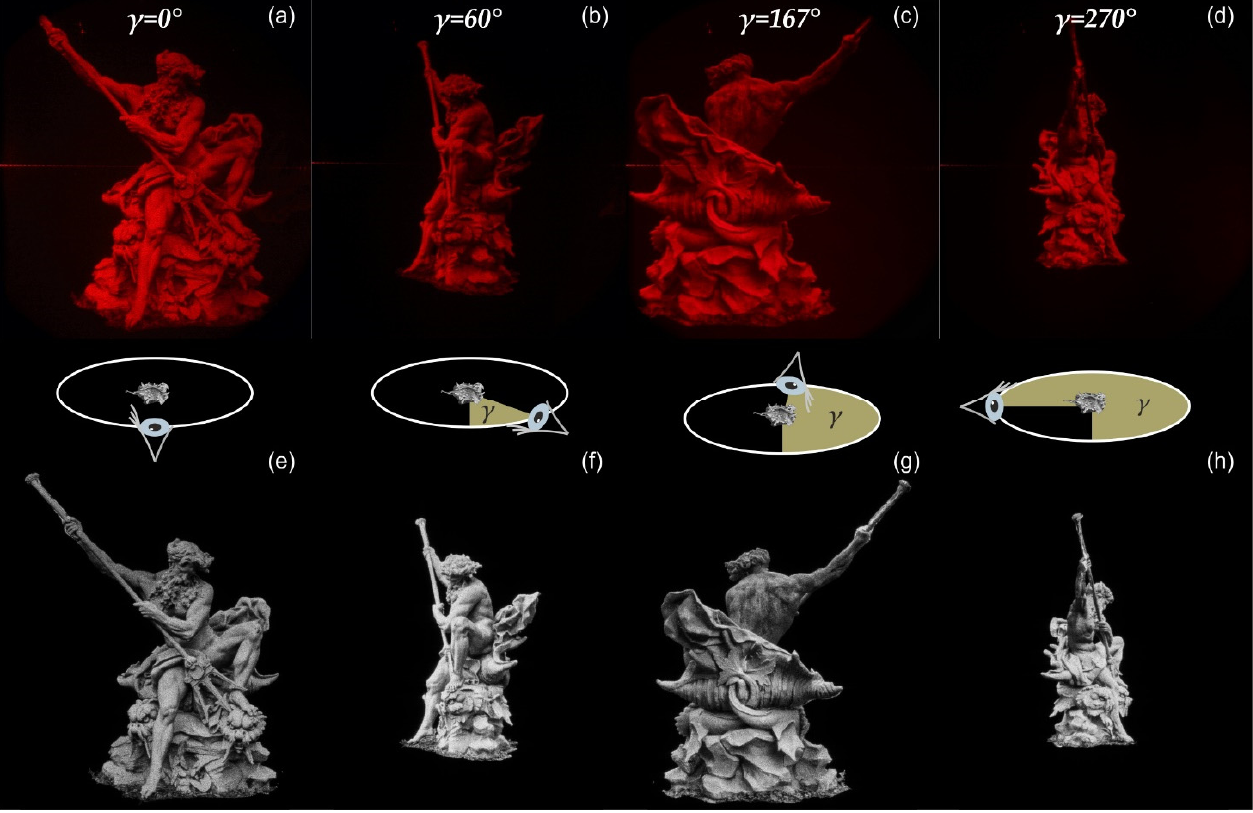
Figure 9. The optical ( a – d ) and numerical ( e – h ) reconstruction of CGHs of Neptune statue, observed from the angles: 0°, 60°, 167° and 270°.